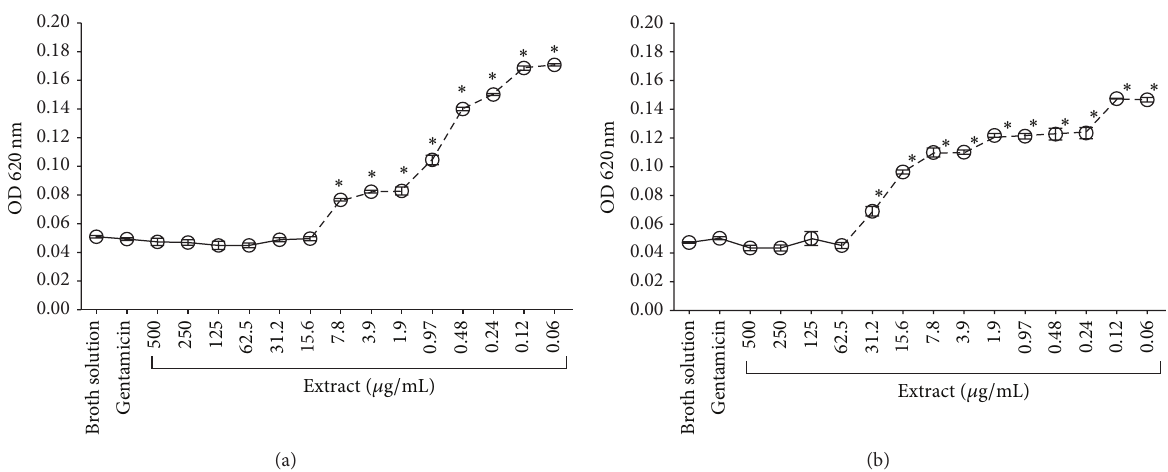
Figure 2: MIC of the oily and ethanolic phases from Mammea americana extract against Streptococcus mutans . (a) The minimum concentration of the oily phase which inhibited bacterial growth was 15.6 𝜇 g/mL, (b) whereas the MIC of ethanolic phase was 62.5 𝜇 g/mL. Each symbol represents the mean ± SEM for each concentration tested ( 𝑛 = 4 per ( 𝜇 g/mL)). 𝑃 value < 0.05: ( ∗ ); Kruskal-Wallis test and Dunnett’s posttest.